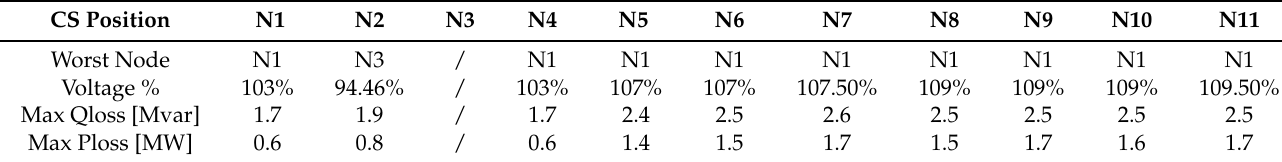
Figure 21. Load coefficients. Table 13. Summary of the performances by changing CS’s node.